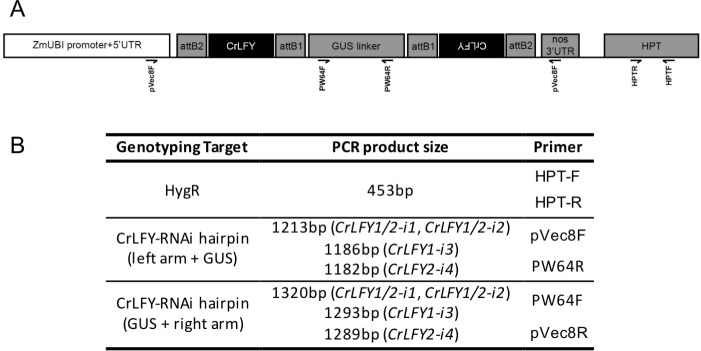
Binding site of CrLFY RNAi genotyping PCR primers.(A) Generalized schematic of CrLFY RNAi T-DNA with the relative position of primers used in genotyping PCR (see Figure 6—figure supplement 5, Figure 7—figure supplement 1) marked. The primer binding sites are common to all four RNAi constructs, with the size of the hairpin-containing PCR products varying due to the insertion of different CrLFY target sequences. (B) Primer combinations for each genotyping reaction and expected PCR product sizes for each CrLFY RNAi construct. Primer sequences are listed in the Key Resources Table.